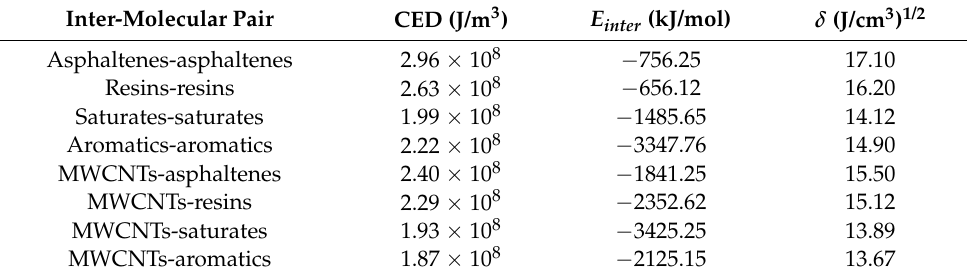
Table 3. Intermolecular interaction energy results of MWCNTs-MA. Inter-Molecular